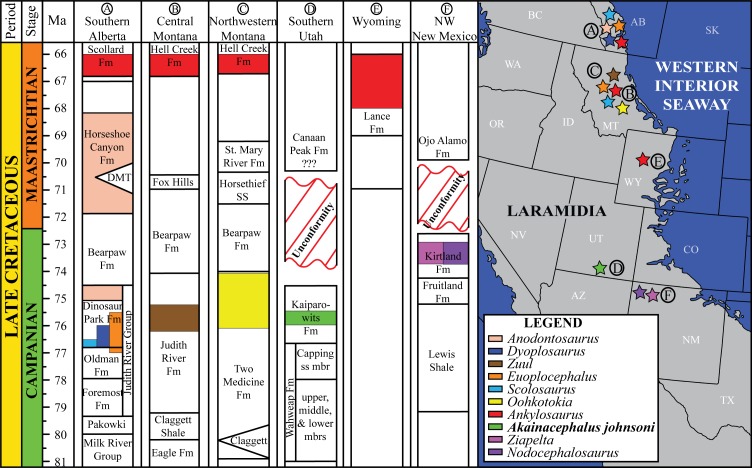
Distribution of Late Cretaceous Laramidian ankylosaurid dinosaurs.Overview of stratigraphic, temporal, and biogeographic distribution of Late Cretaceous (upper Campanian–upper Maastrichtian) ankylosaurid dinosaurs, including Akainacephalus johnsoni, across northern Laramidian (Alberta, Montana, Wyoming), and southern Laramidian (Utah, New Mexico) basins. Noticeable is the higher number of taxa and more widespread distribution of ankylosaurids in northern Laramidia. Colored bars within stratigraphic formations represent ankylosaurid taxa and their respective temporal range. Paleogeographic map modified after Sampson et al. (2010). Stratigraphic intervals modified after Arbour & Currie (2013a); Roberts et al. (2013); Johnson, Nichols & Hartman (2002).